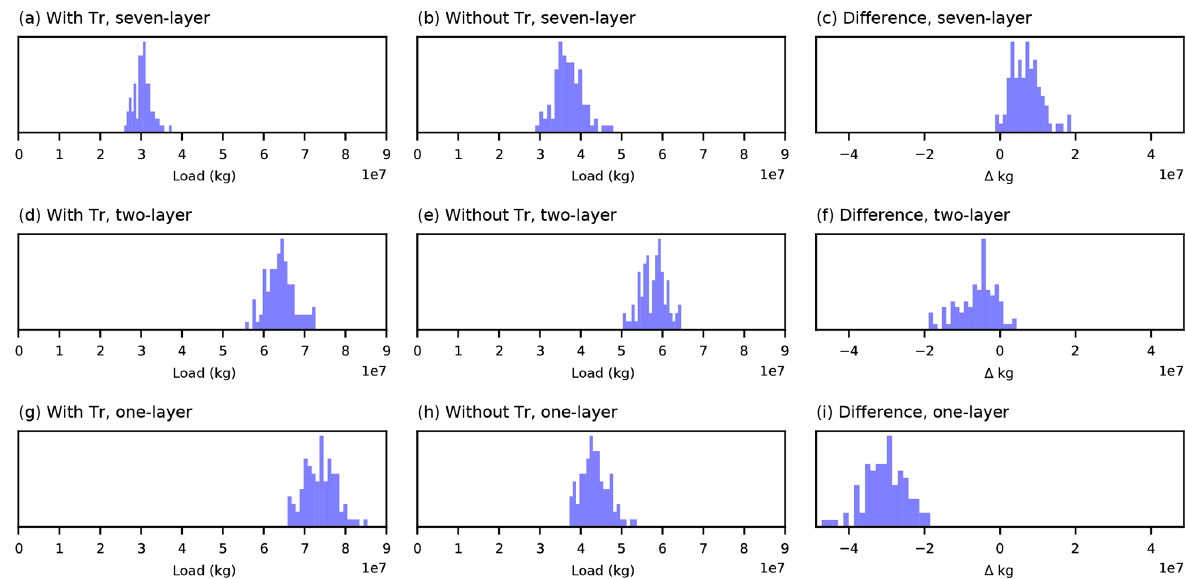
Figure 4. Comparison of posterior probability density functions (PDFs) for the Firth forecast. The left column (a, d, g) allows for the identification of bias as a result of both model simplification and tritium (Tr) assimilation. By comparing to the middle column (b, e, h) , model simplification-induced bias can be separated from that induced by assimilating tritium observations. The isolation of tritium assimilation- induced bias evident with different simplified models is shown in the right column (c, f, i) . Including tritium observations in the conditioning of the one-layer and two-layer models (g, d) yields significant bias compared to the seven-layer PDF (a) . However, if tritium observations are excluded from conditioning, the one-layer and two-layer PDFs (h, e) have considerably less bias compared to the corresponding seven-layer PDF (b) . The differences in the PDFs (c, f, i) show that the tritium observations have the greatest biasing effect on the Firth forecast for the one-layer